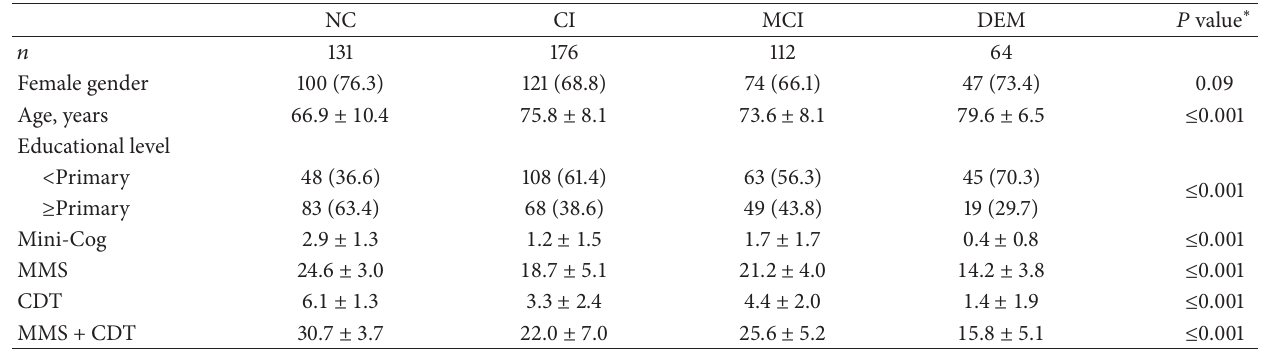
Table 2: Demographic characteristics and test results by cognitive diagnosis.